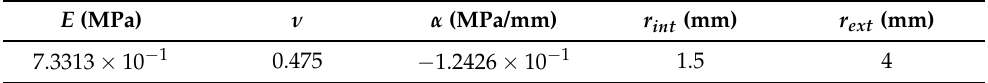
Table 2. Model parameters: Young’s modulus E , Poisson ratio ν and the ballast coefficient α .